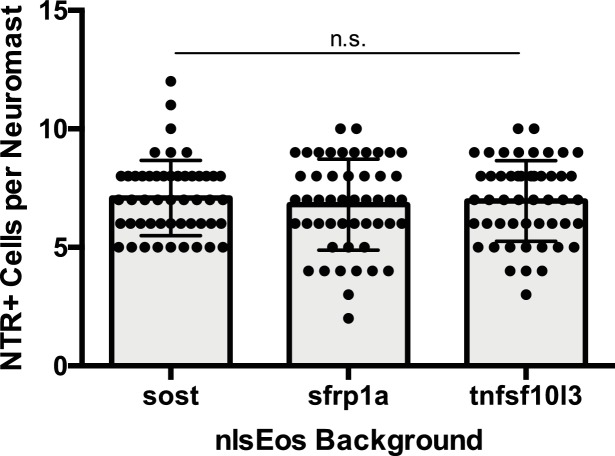
Expression of nlsEos transgenes does not alter number of sost:NTR-GFP cells.Total number of sost:NTR-GFP cells per neuromast in sost:nlsEos (sost), sfrp1a:nlsEos (sfrp1a), and tnfsf10l3:nlsEos (tnfsf10l3) fish. Sost: 7.08 ± 1.59, n = 50 neuromasts (10 fish); Sfrp1a: 6.80 ± 1.92, n = 50 neuromasts (10 fish); Tnfsf10l3: 6.96 ± 1.70, n = 50 neuromasts (10 fish); mean ± SD; Kruskal-Wallis test, Dunn’s post-test, p>0.9999 (all comparisons).10.7554/eLife.43736.035Figure 11—figure supplement 2—source data 1.Expression of nlsEos transgenes does not alter number of sost:NTR-GFP cells